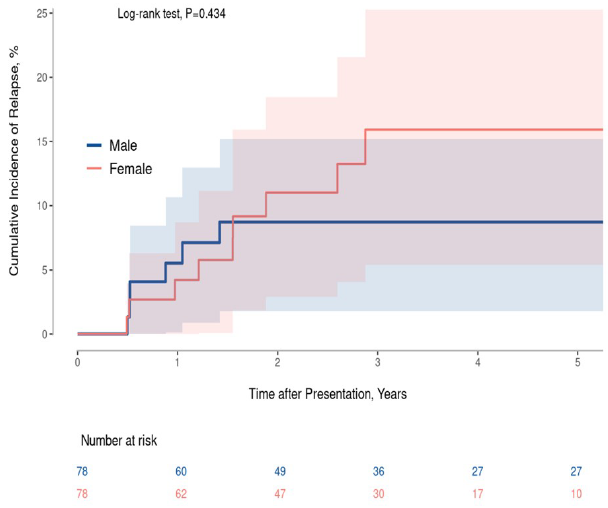
Figure 1. Three-year cumulative incidence of relapsed PJI in males and